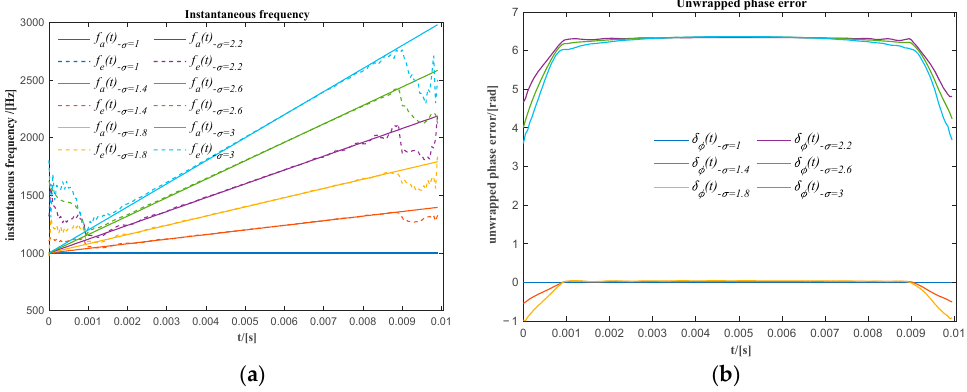
Figure 4. ( a ) The actual and the extracted instantaneous frequencies for different relative frequency ratios; ( b ) the phase error of the extracted unwrapped phase before phase shifting.